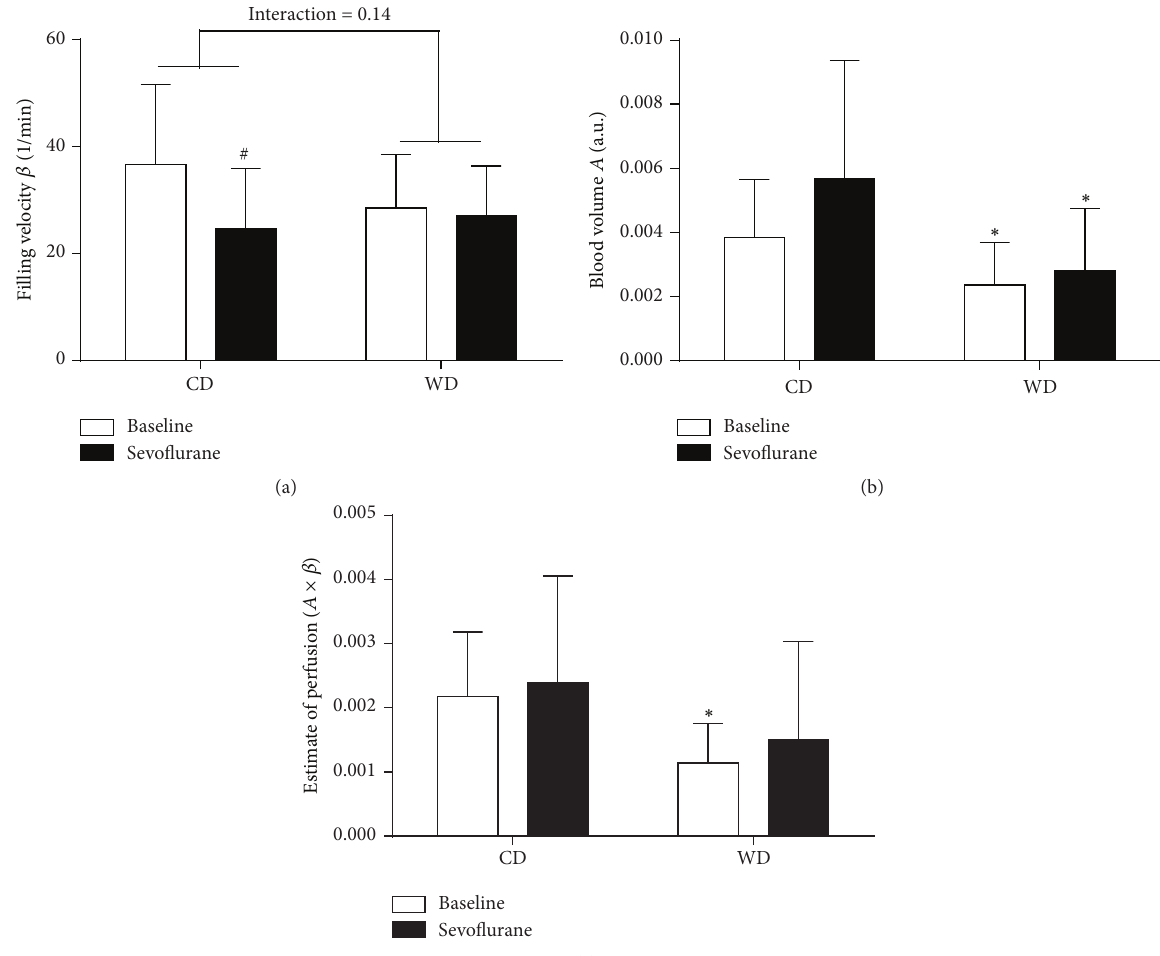
Figure 2: Effect of sevoflurane on myocardial perfusion in prediabetic rats. Microvascular blood volume 𝐴 (a), microvascular filling velocity 𝛽 (b), and estimate of perfusion (c) measured with contrast echocardiography in rats fed a control diet (CD) or western diet (WD) for 8 weeks during baseline conditions and after 5 minutes of sevoflurane exposure. Data are expressed as mean ± SD, 𝑛 = 9 – 13 ; two-way ANOVA with Bonferroni post hoc analyses, ∗ 𝑝 < 0.05 diet effect, # 𝑝 < 0.05 sevoflurane effect.